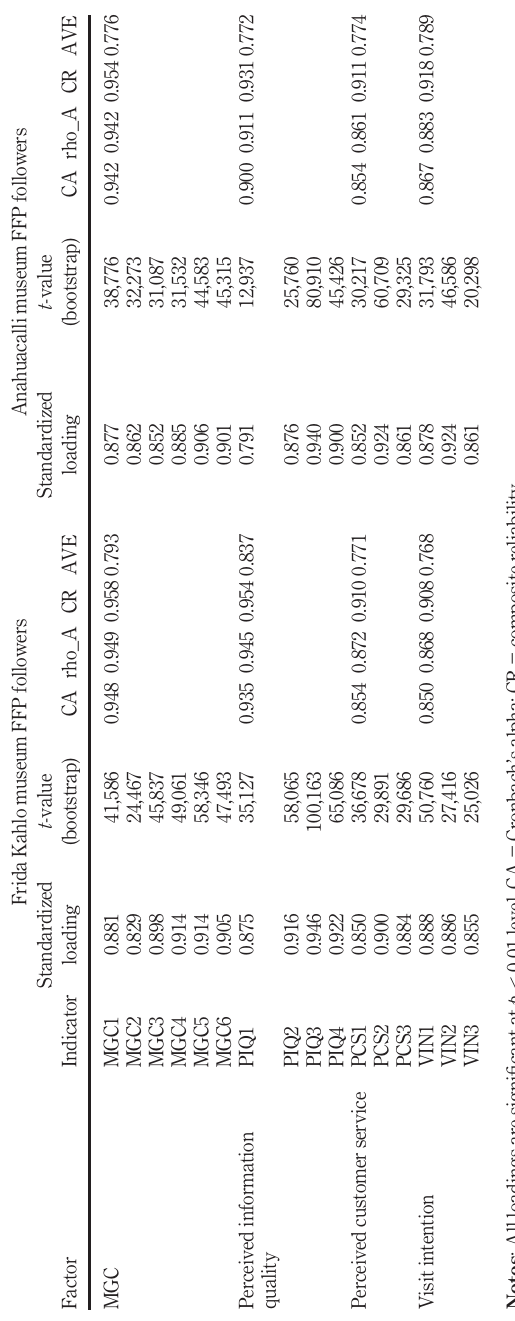
Table III. Reliability and convergent validity of the measurement